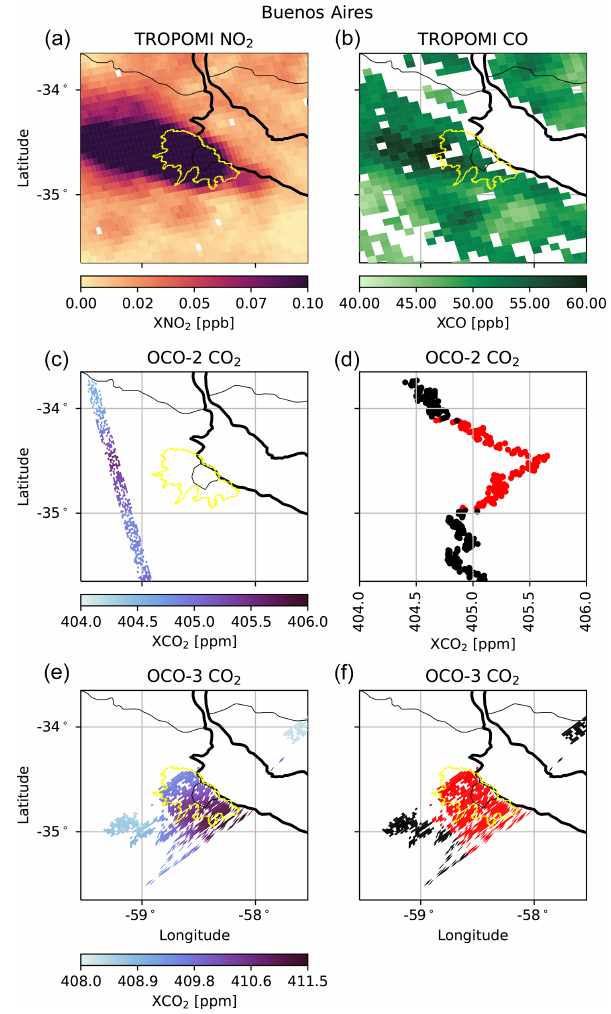
Figure 1. Examples of the various satellite instrument ground tracks over Buenos Aires taken on 11 January 2019 (a–d) and 19 September 2019 (e, f) . The yellow outline indicates the city boundaries. The top two panels show the TROPOMI NO 2 (a) and CO (b) . The middle two panels show the OCO-2 ground track downwind of Buenos Aires (c) and the CO 2 measurements as a function of latitude (d) . Red points indicate the urban enhancement plume, and black points are considered outside the plume. The bot- tom two panels show the OCO-3 snapshot area mapping (SAM) mode measurements over Buenos Aires (e) . Panel (f) distinguishes the region of enhanced CO 2 in red from the background region in